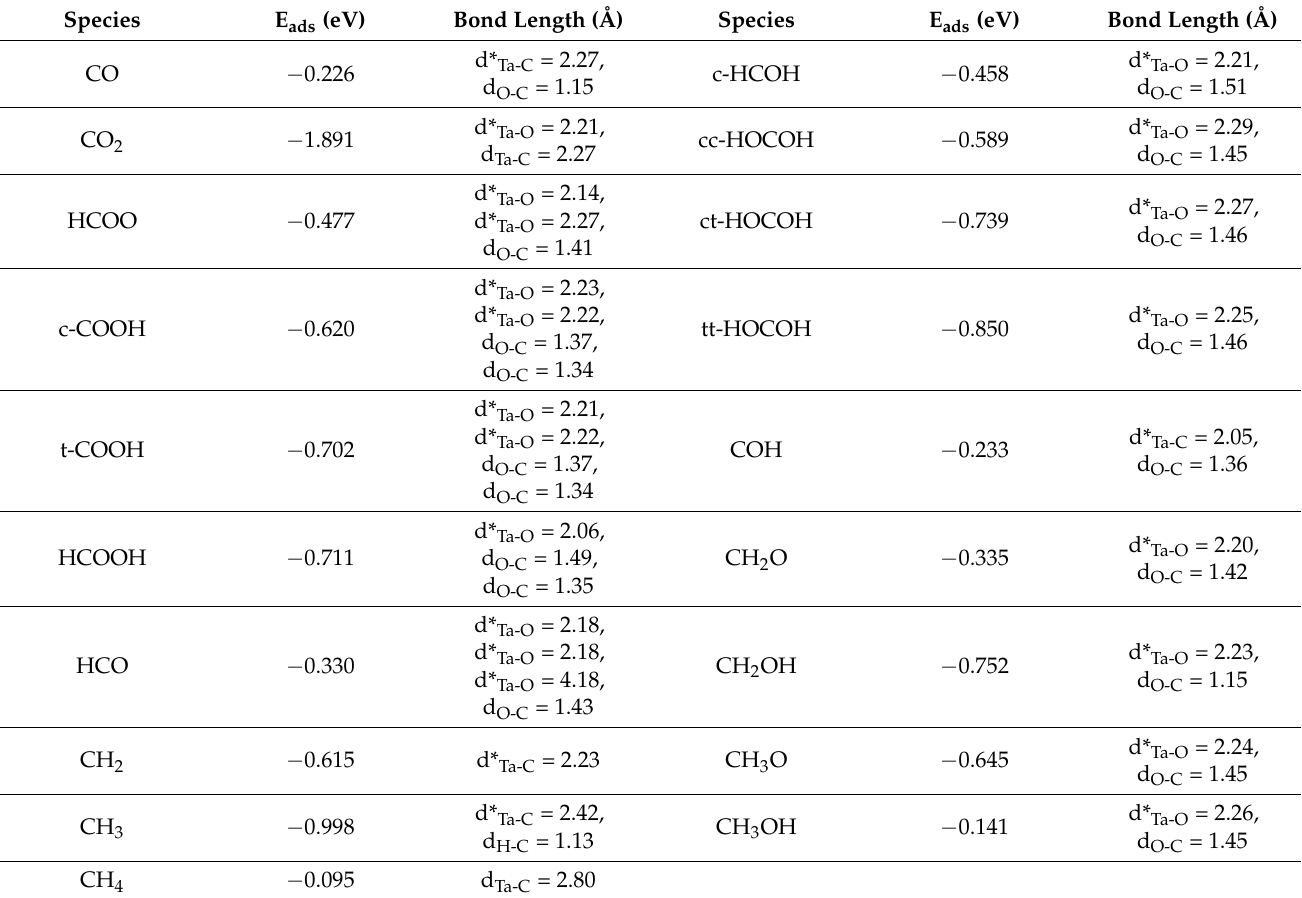
Table 1. The preferred adsorption geometric information and adsorption energies for all intermediates on the TaC (111) surface during CO 2 hydrogenation on the TaC (111)